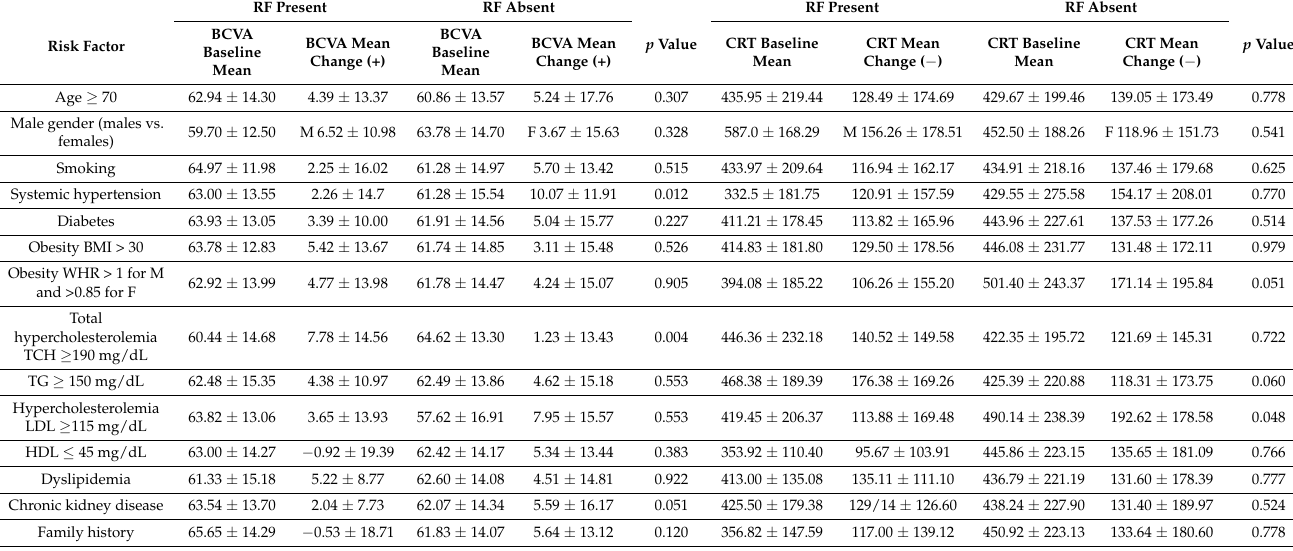
Table 4. The change of BCVA and CRT at 12 months according to presence or absence of a specific risk factor. P values refer to the statistical significance of the difference in that change between patients with a specific risk factor present and absent.